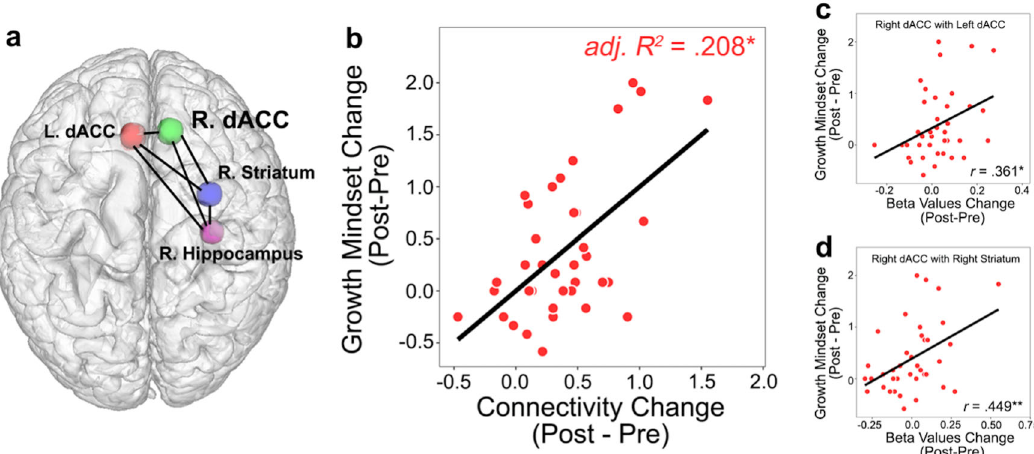
Fig. 3 Plasticity of dorsal ACC – subcortical functional connectivity associated with increases in growth mindset with cognitive training. a Brain areas and relative strength of training-related changes in task-based connectivity associated with growth mindset gains. b Changes in connectivity amongst 4 brain regions (6 ROI-to-ROI links shown in ( a )) jointly contributes to changes in growth mindset in the training group. c , d Changes in connectivity of ( c ) the right dorsal ACC with left dorsal ACC and those of ( d ) the right dorsal ACC with right striatum are signi fi cantly associated with changes in growth mindset in the training